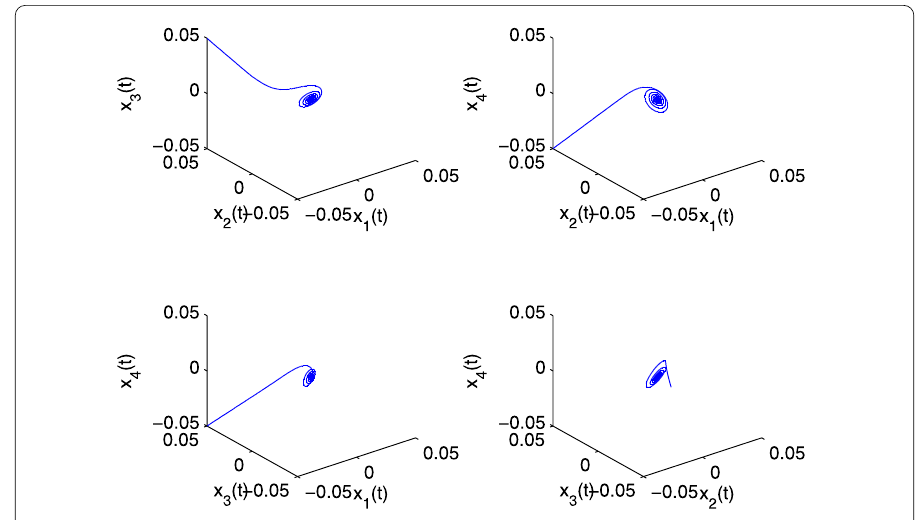
Figure 15 Phase portrait of system (5.4) with φ = 0.96, τ = 0.22 < τ 0 = 0.2427